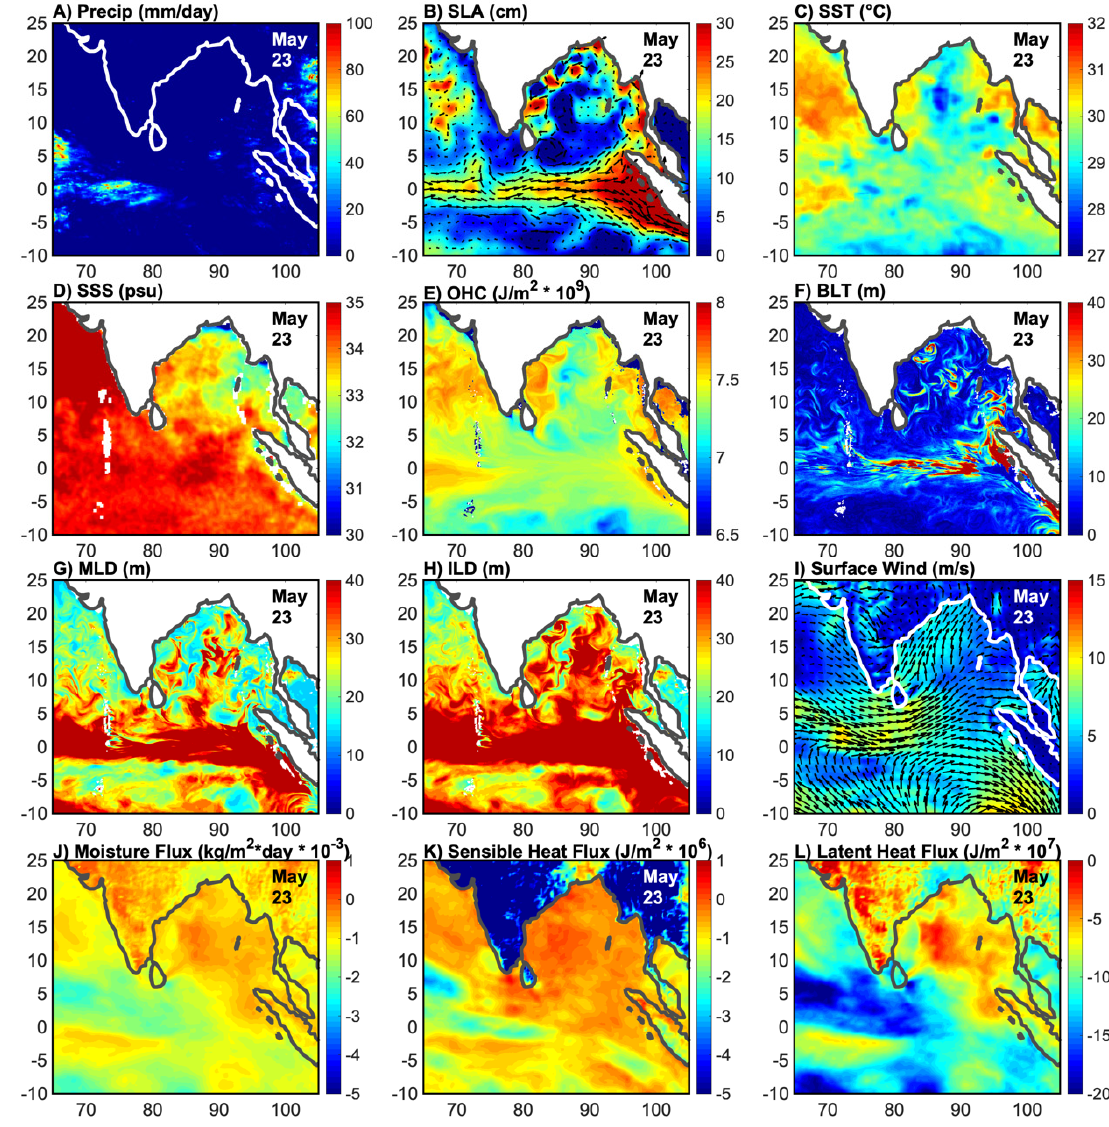
Figure 4. Multiparameter analysis of the Bay of Bengal on May 23, 2020 after the storm in ( a ) Global PrecipitationMeasurement(GPM)precipitationrate(mm / day); ( B )CopernicusMarineandEnvironment Precipitation Measurement (GPM) precipitation rate (mm/day); ( b ) Copernicus Marine and Monitoring Service (CMEMS) sea level anomalies (SLAs) (cm) overlaid with geostrophic currents (cm / s); Environment Monitoring Service (CMEMS) sea level anomalies (SLAs) (cm) overlaid with ( C ) Nucleus for the European Modeling of the Ocean (NEMO) sea surface temperature (SST) data ( ◦ C); ( D ) NEMO sea surface salinity (SSS) data (psu); ( E ) 0–30 m ocean heat content (OHC; J / m 2 * 10 9 ) geostrophic currents (cm/s); ( c ) Nucleus for the European Modeling of the Ocean (NEMO) sea surface calculated from NEMO; ( F ) barrier layer thickness (BLT; m) calculated from NEMO; ( G ) mixed layer temperature (SST) data (°C); ( d ) NEMO sea surface salinity (SSS) data (psu); ( e ) 0–30 m ocean heat depth (MLD; m) calculated from NEMO; ( H ) isothermal layer depth (ILD; m) calculated from NEMO; content (OHC; J/m 2 * 10 9 ) calculated from NEMO; ( f ) barrier layer thickness (BLT; m) calculated from ( I ) Cross-Calibrated Multi-Platform version 2 (CCMPv2) surface wind magnitude (m / s; shaded) and NEMO; ( g ) mixed layer depth (MLD; m) calculated from NEMO; ( h ) isothermal layer depth (ILD; m) vectors; ( J ) ERA5 instantaneous moisture flux (kg / m 2 *day*10 − 3 ); ( K ) ERA5 surface sensible heat flux calculated from NEMO; ( i ) Cross-Calibrated Multi-Platform version 2 (CCMPv2) surface wind (J / m 2 * 10 6 ); and ( L ) ERA5 surface latent heat flux (J / m 2 * 10 7 magnitude (m/s; shaded) and vectors; ( j ) ERA5 instantaneous moisture flux (kg/m 2 *day*10 − 3 ); ( k ) ERA5 surface sensible heat flux (J/m 2 * 10 6 ); and ( l ) ERA5 surface latent heat flux (J/m 2 * 10 7 ).